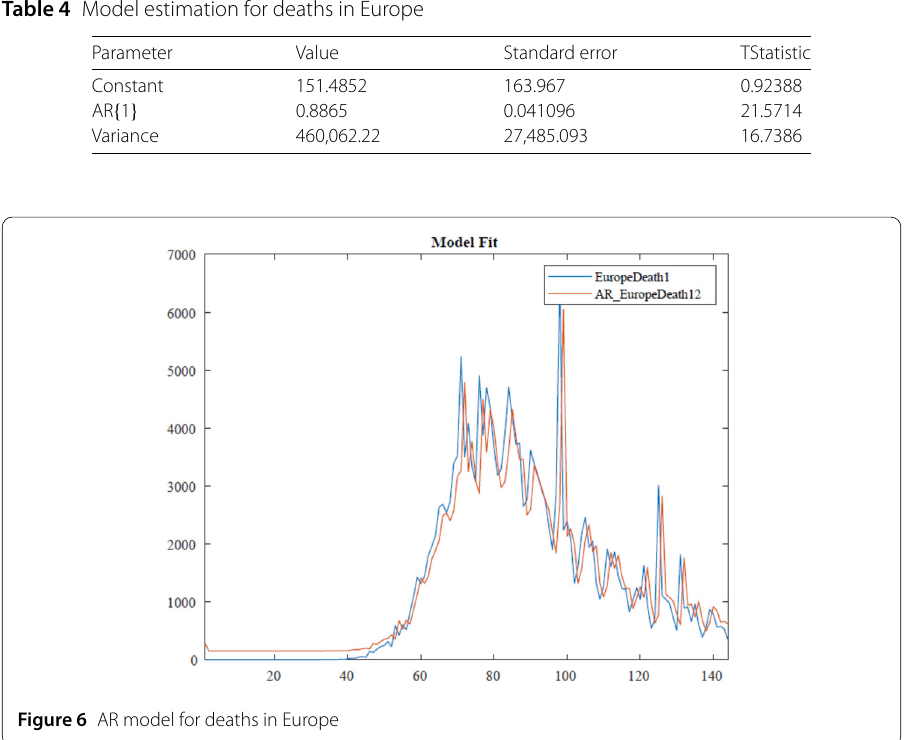
Figure 6 AR model for deaths in Europe